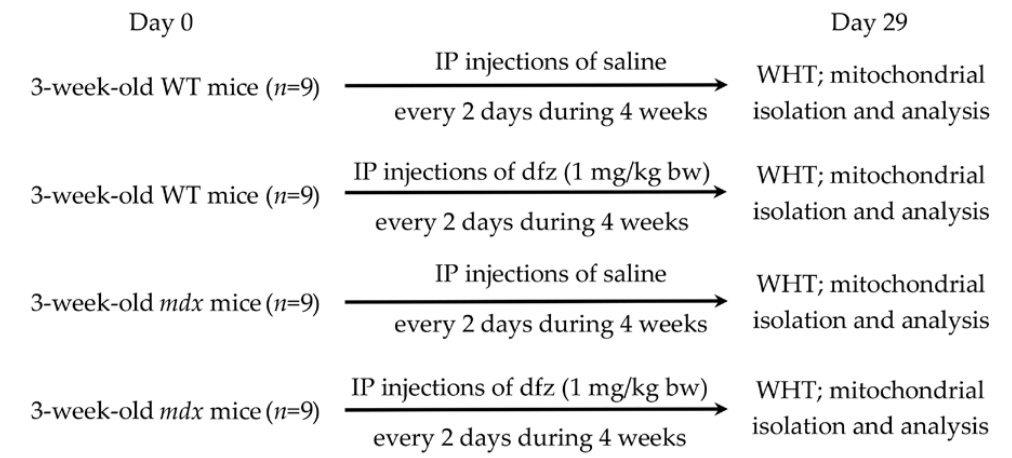
Figure 10. The experimental protocol of the study, IP: intraperitoneal; WHT: wire hanging